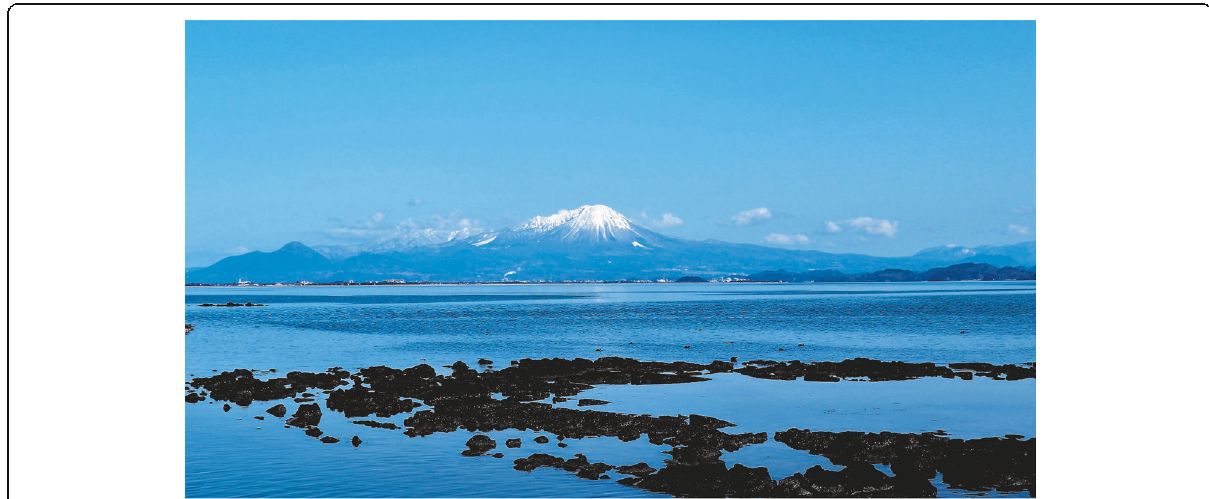
Fig. 13 Mt Daisen is the largest stratovolcano in the SW-Japan arc. The snow-capped summit in the foreground is build up of several lava domes, which have been the source of a large number of block and ash flows, their deposits now found in the pyroclastic apron of the young complex. The sub-circular structure in the foreground is a lava blister, belonging to the basaltic lava flows of Daikonjima island, a contemporary monogenetic volcano of the young